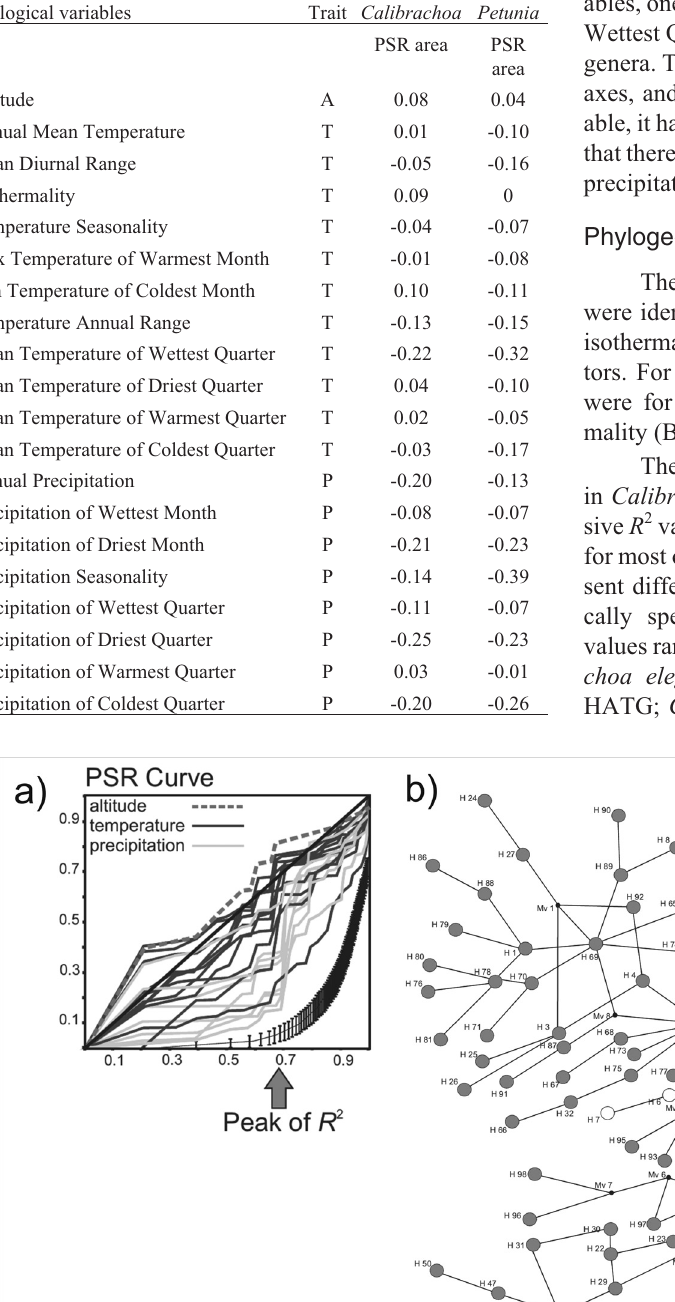
Table 2 - Bioclimatic variables used to define altitude (A), temperature (T), and precipitation (P) traits. Ecological variables